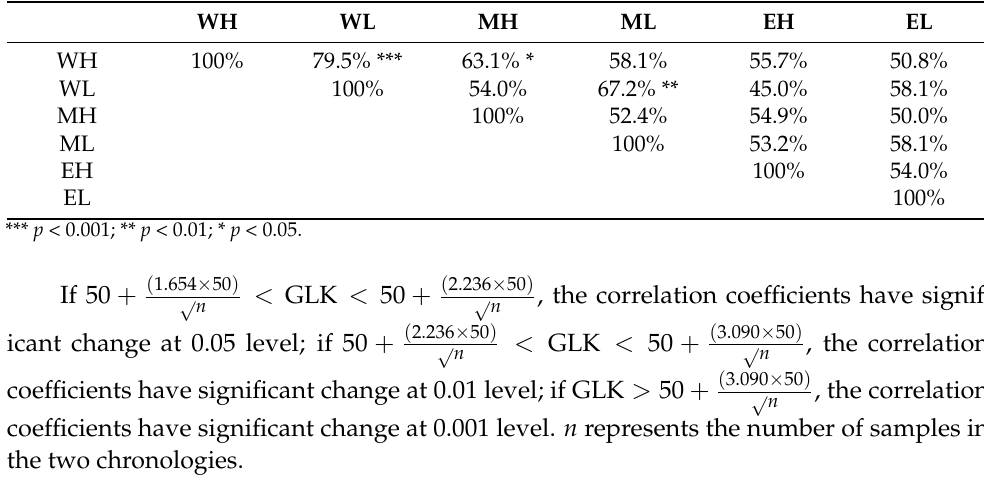
Table 3. GLK between the six chronologies